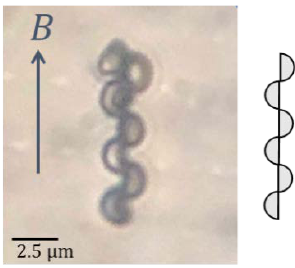
Figure 10. Result for self-organization of nickel-coated hemispherical Janus particles like a chain. When a magnetic field B is applied, particles are magnetized one by one and attract each other.